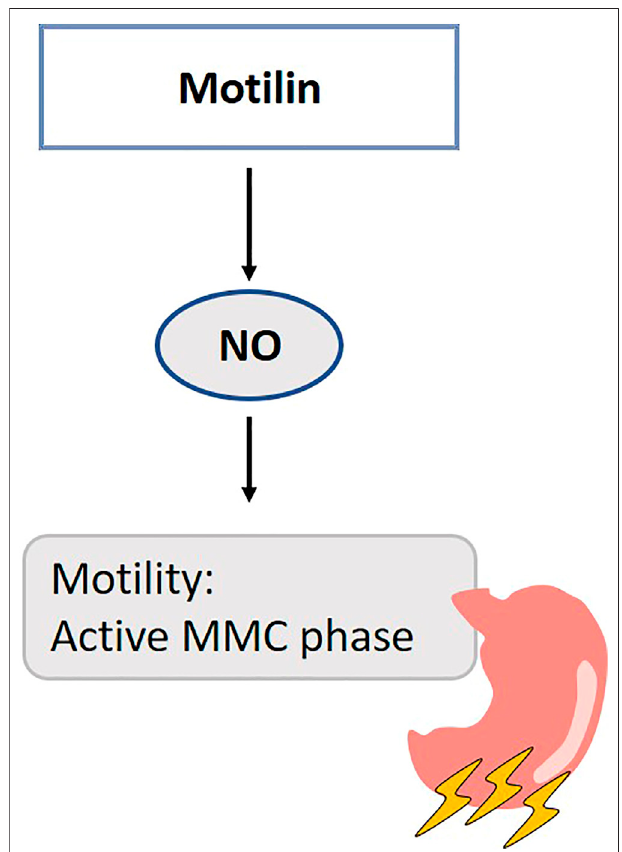
FIGURE 7 | Role of gasotransmitters on motilin ’ s physiological functions. Solid lines are clear evidence – based on blockers and substrate administration. NO modi fi es the contractile response of motilin in the antral part of the stomach during the interdigestive state. NO, Nitric oxide; MMC, Migrating motor